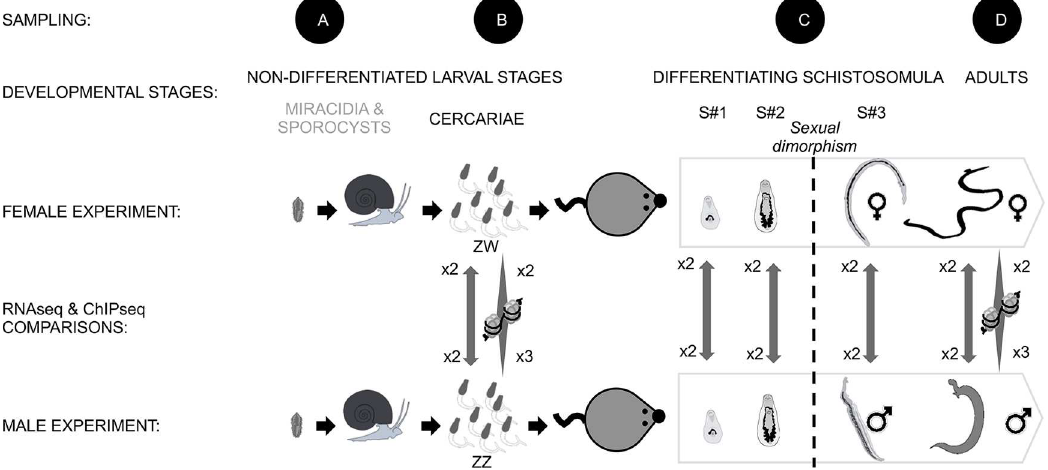
Fig 1. Experimental strategy to compare molecular events occurring through male and female S . mansoni development. (A) A monomiracidial infection of mollusks was first performed in order to obtain either ZZ male or ZW female clonal cercariae. (B) The sex of the cercarial clones was determinedby PCR of female-specific sequences and unisexual infection of mice was then performed. For the molecularstudy, we recovered one free-livingundifferentiated stage of the parasite: cercariae; and four intra-vertebrate stages: (C) the three differentiating schistosomulum stages and (D) the adult stage. The schistosomulum stages are characterized by the onset of sexual dimorphism between s#2 and s#3, and are describedmore in details in the S1 protocol. For these five stages, we compared the male and female transcriptomes using RNAseq (biologicalduplicate). For the non-differentiated cercariae and the sexuallydifferentiated adults we also performed a ChIPseq in duplicate for males and triplicate for